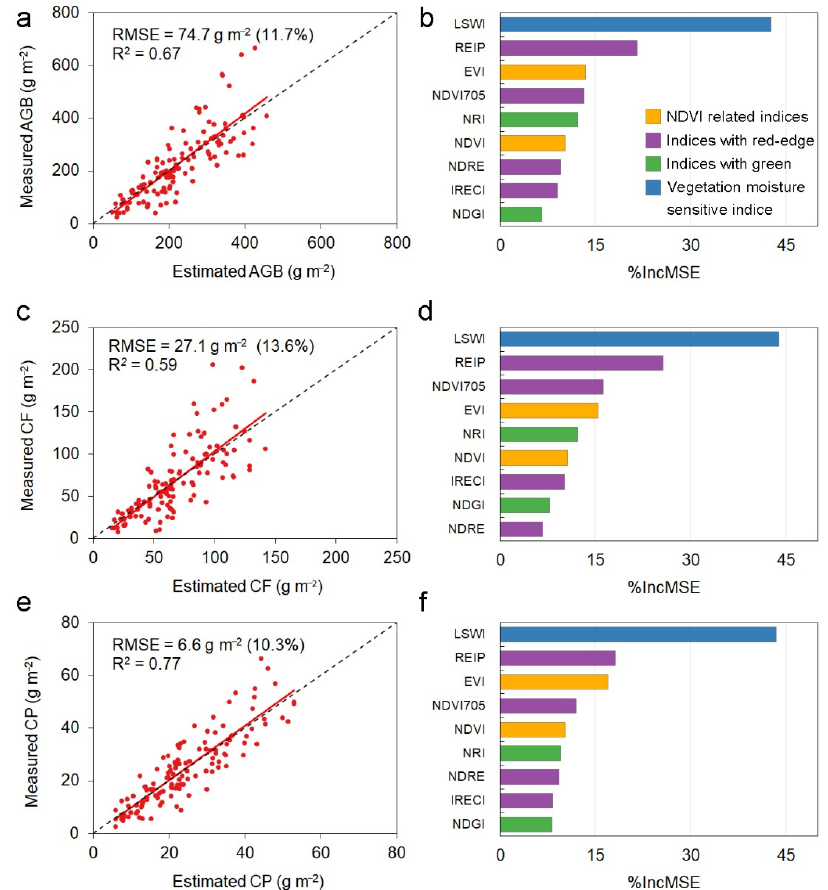
Figure 4. Accuracies and predictor importance of Random Forest models for forage biomass ( a , b ), crude fiber per area ( c , d ), and crude protein per area ( e , f ). Percentages in brackets indicate NRMSE. %IncMSE indicates the percent increase in MSE (Mean Squared Error) of predictions as a result of the variable being permuted (values randomly shuffled). Variables with higher %IncMSE values are more